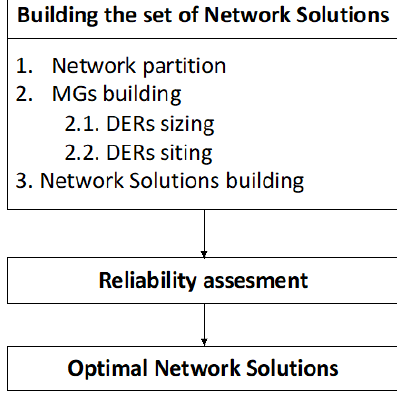
Figure 4. Methodology flowchart.